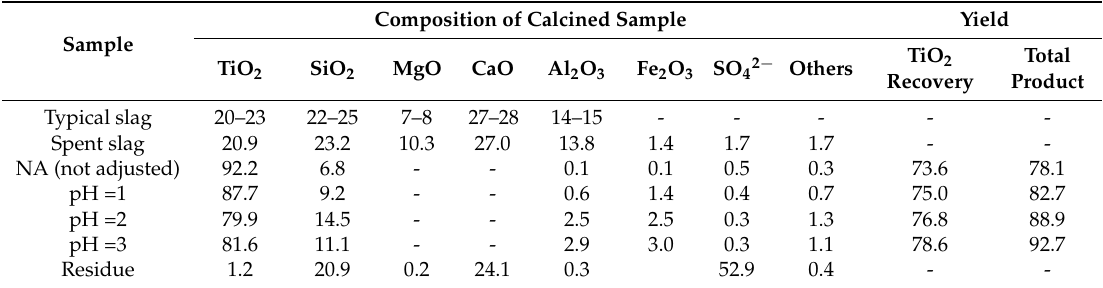
Table 1. Yield and main chemical composition of BFS-TiO 2 supports obtained under different hydrolytic pH values (mass